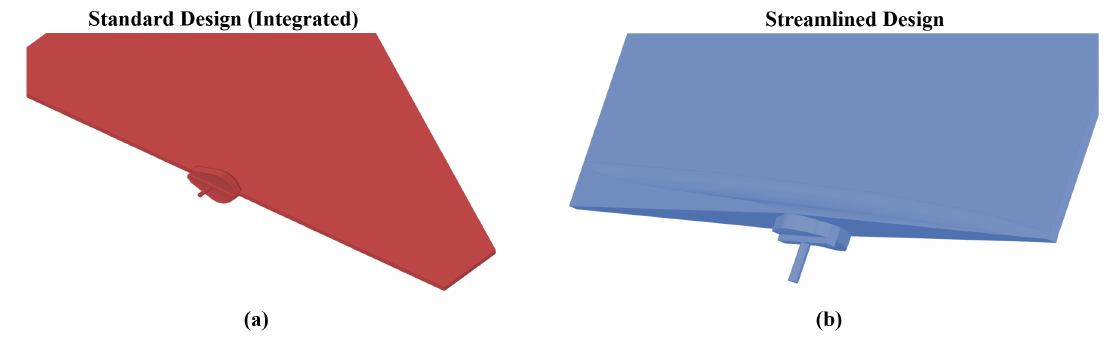
Figure 15. Redesign of rear control surface, ( a ) with a simple integration of the two functions and ( b ) with a re-design to streamline the airflow around the